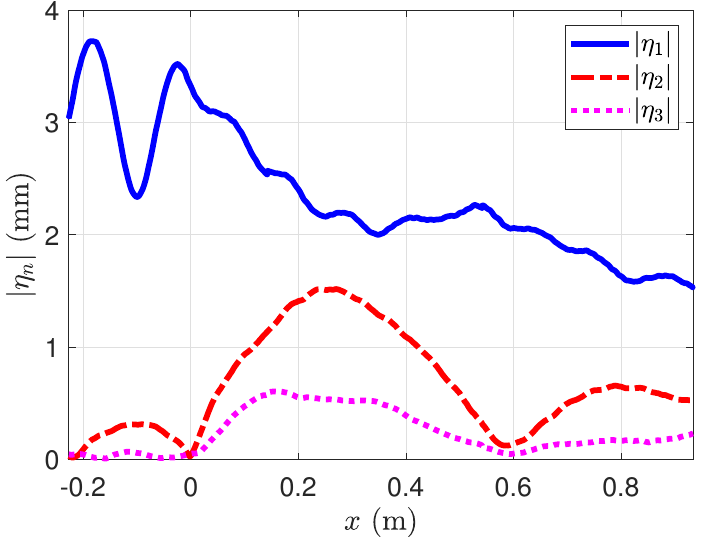
η n ( x ) with n = 1,2,3 measured with Fourier |